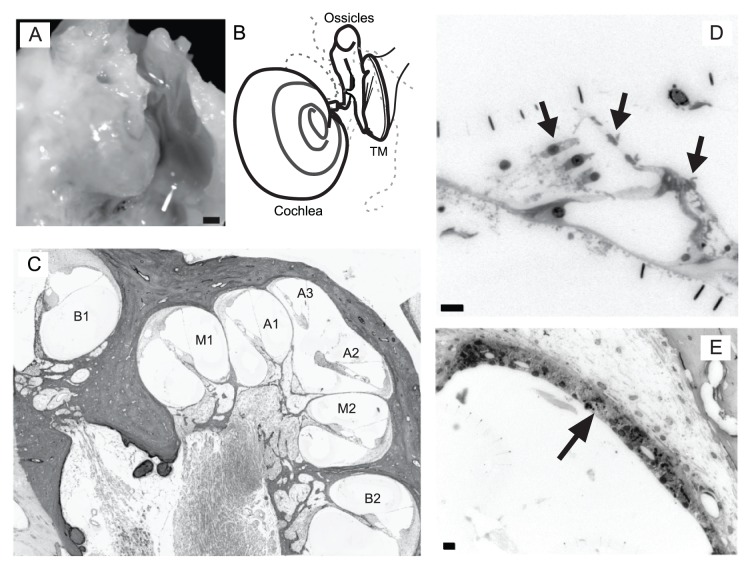
Histology of the rhesus monkey cochlea.This specimen came from the 15 year old monkey. Whole mount (A), illustration (B) and semi-thin mid-modiolar section (C) of the rhesus monkey cochlea. Semi-thin section revealing inner and outer hair cells are shown in D. Arrows indicate stereocilia or soma of inner and outer hair cells. Semi-thin section revealing the stria vascularis are shown in E. Different levels of the base (B1,2), middle (M1,2) and apical (A1,2,3) turns are indicated in panel C. TM = tympanic membrane. Scale bar 1 mm (A), 10 µm (D,E).